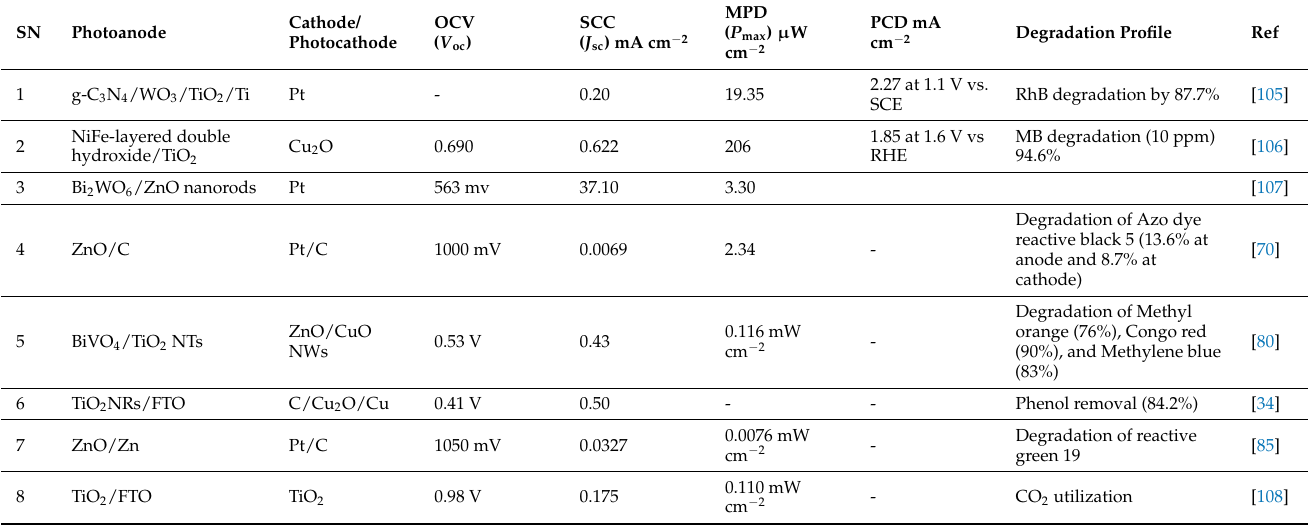
Table 2. Some electrochemical parameters of